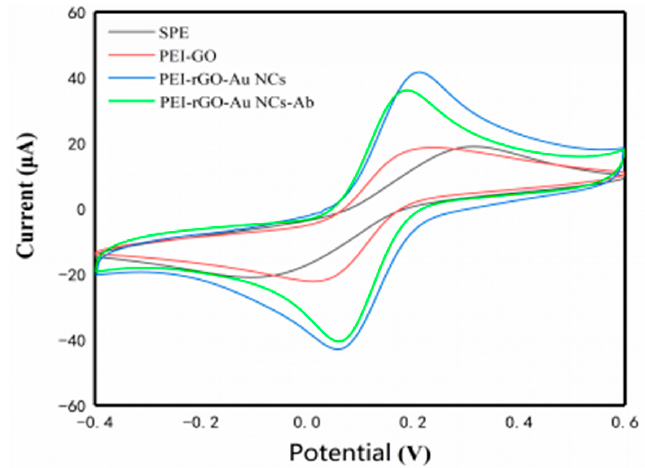
Figure 4. Characterization and analytical performance of the electrochemical sensor. Typical CV studies of the SPE, PEI-rGO (6 µ L, 0.5 mg / mL), PEI-rGO-AuNCs (6 µ L, 0.5 mg / mL), and PEI-rGO-AuNCs–antibody (3 µ L, 100 µ g / mL)-modified electrode in 5.0 mM K 3 (Fe(CN) 6 ), 1.0 mM K 4 Fe(CN) 6 , and 0.1 mM KCl.